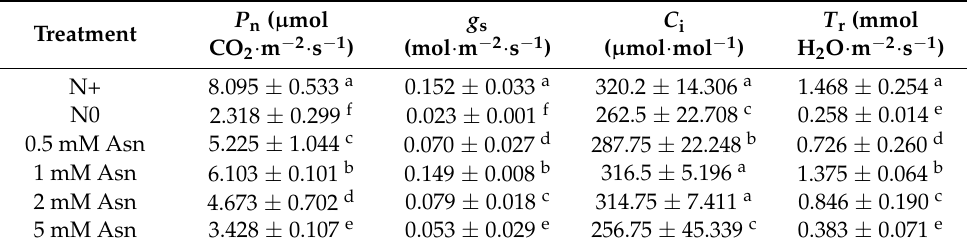
Table 2. Photosynthetic parameters of the poplar ‘Nanlin895’ under different asparagine (Asn)